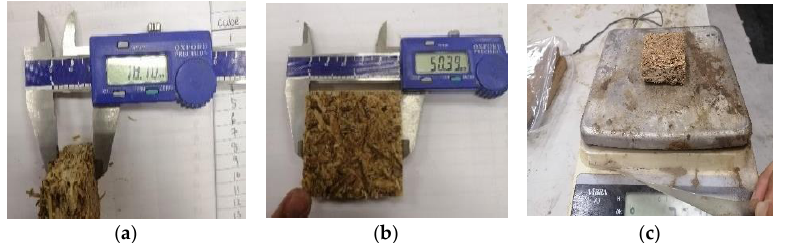
Figure 7. Each specimen being measured for its ( a ) thickness; ( b ) area; and ( c ) weight to determine the density of particleboard determination of swelling in thickness after immersion in water (BS EN 317:1993).